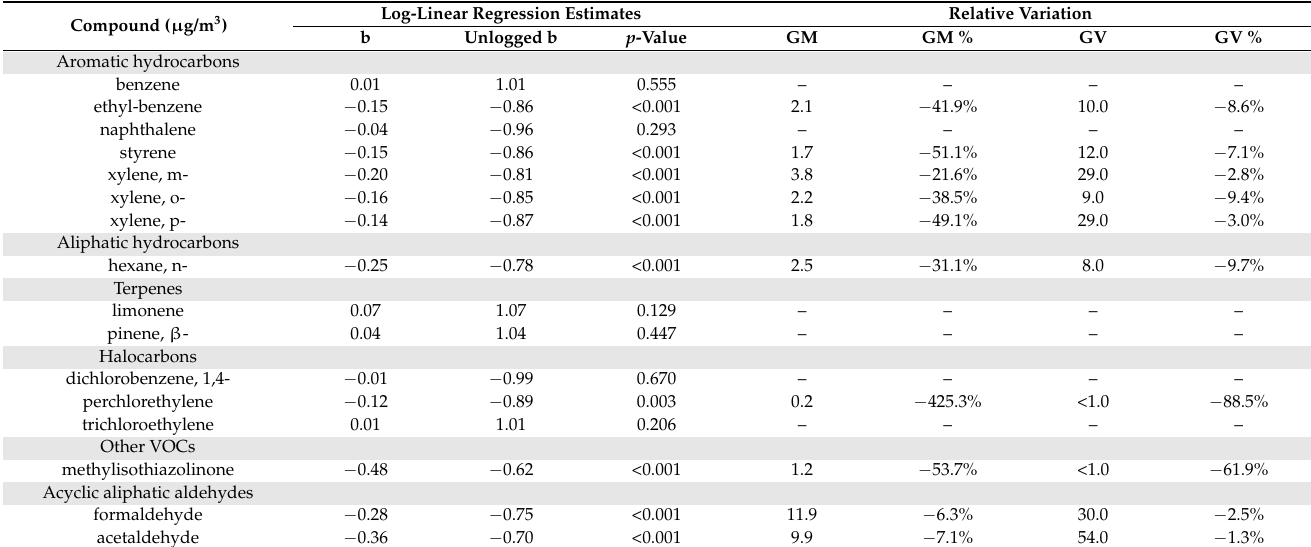
Table 3. Temporal analysis of concentrations for selected hazardous air pollutants.